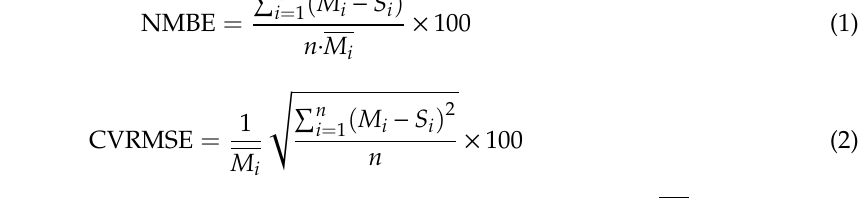
measurement values. Energies 2020 , 13 , x FOR PEER REVIEW